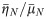
Case IV: experiments on signals of cases II and III with imposed temporal uncertainties.We consider temporal shifts corresponding to 2.5% and 5% of the full length of the time series in cases II and III. (a) Δρ at L = 500 as a function of η¯N/μ¯N for shifted signals of case II. (b) Δρ at L = 500 as a function of η¯N/μ¯Wb for shifted signals of case III. Δρ = 0 and η¯N/μ¯N=1 are shown by dashed, bold lines.